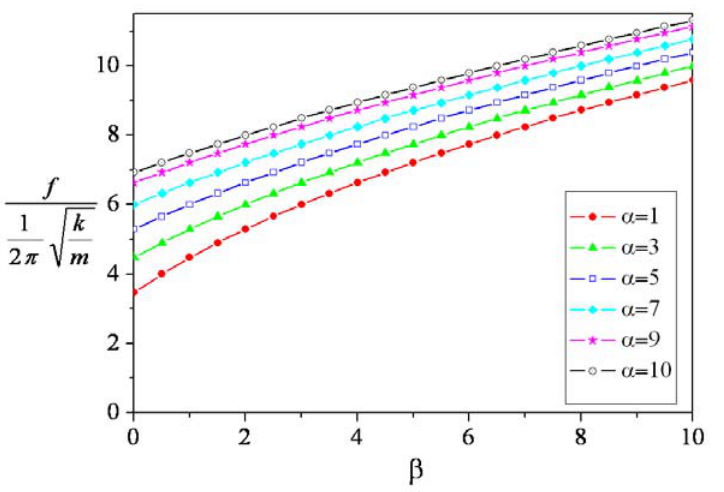
Figure 4. Dimensionless resonant frequency vs. stiffness